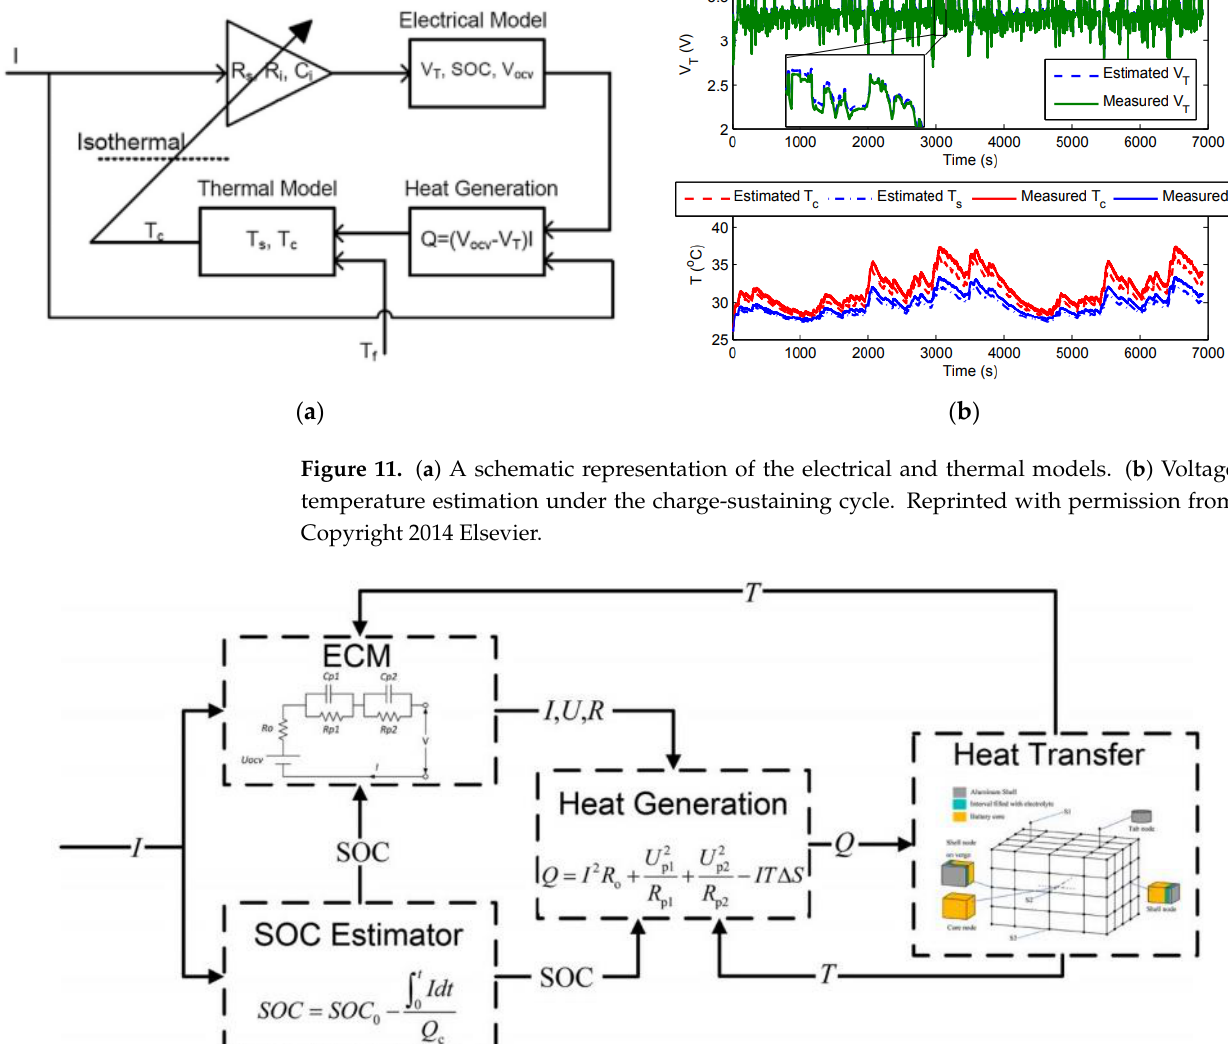
Figure 11. ( a ) A schematic representation of the electrical and thermal models. ( b ) Voltage and tem- perature estimation under the charge-sustaining cycle. Reprinted with permission from [66] . Cop- yright 2014 Elsevier.